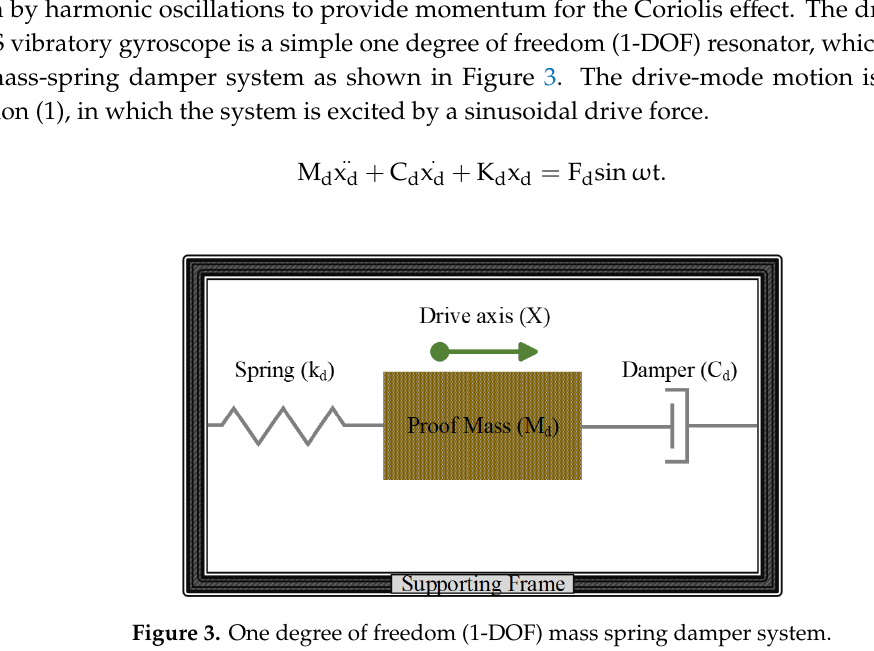
Table 2. Drive-mode analysis parameters for the proposed single-drive, 3-axis MEMS gyroscope. Parameters Value